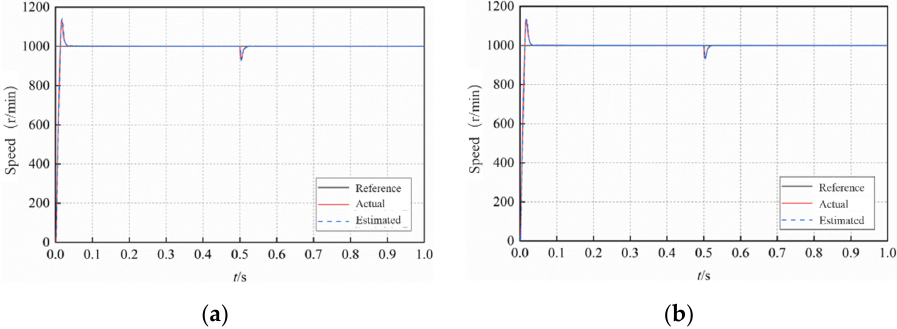
Figure 14. Simulation waveform of motor speed under sudden change of load torque. ( a ) Traditional MRAS algorithm. ( b ) STSM − MRAS algorithm.